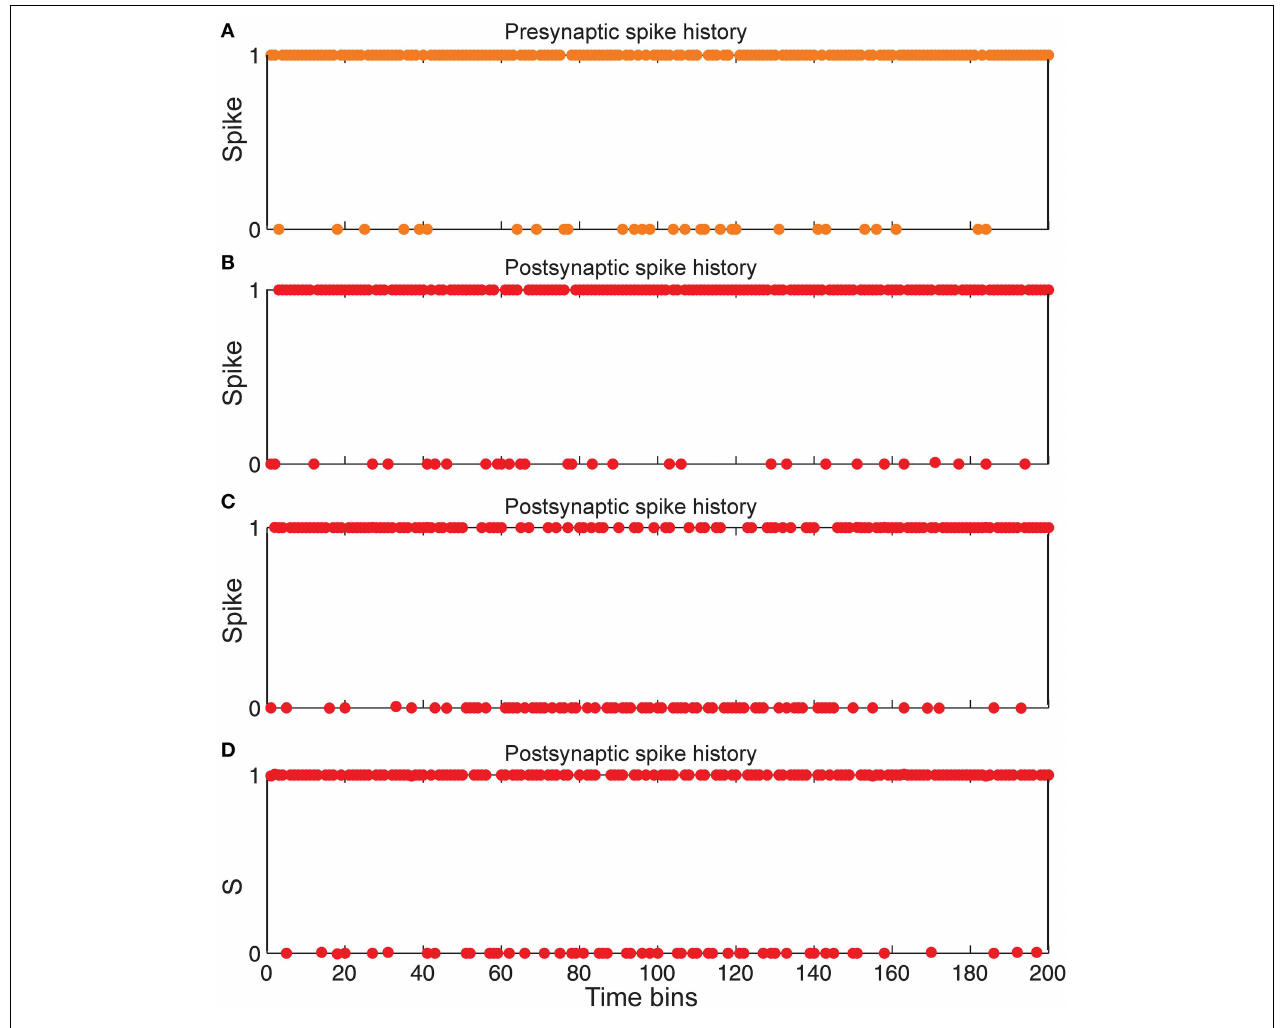
by retrograde messenger. (C) Postsynaptic spiking history in the absence of Hebbian mechanism and in presence of homeostatic regulation of neurotransmitter release induced by retrograde messenger. ( D) Postsynaptic spiking history in presence of both Hebbian mechanism and homeostatic regulation of neurotransmitter release induced by retrograde